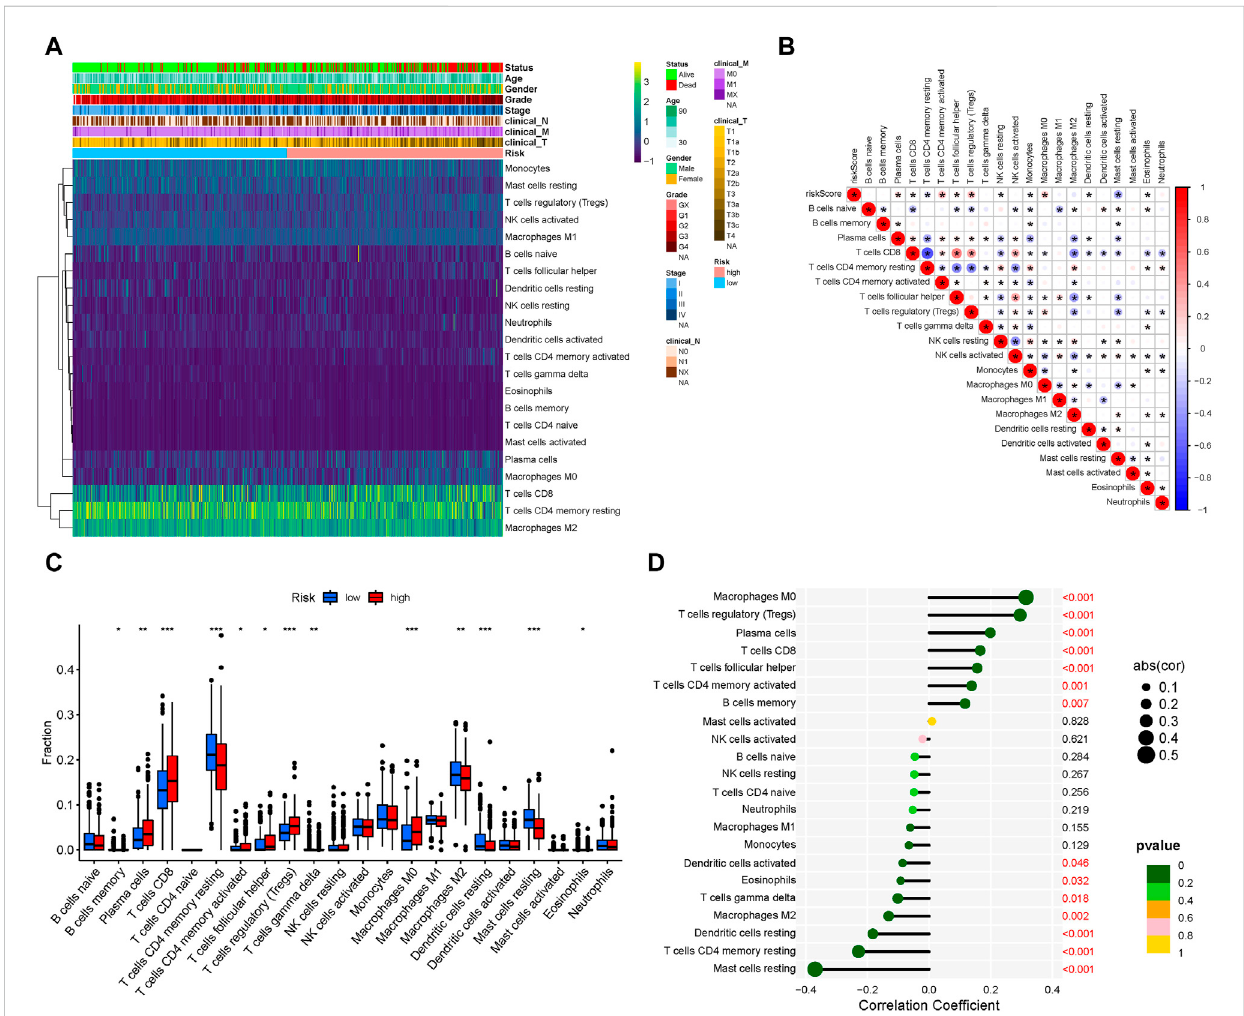
FIGURE 5 Tumor-in fi ltrating immune cell landscape estimation. (A) Heatmap of 22 in fi ltrating immune cell types in the TCGA-KIRC dataset. (B) Correlation between different in fi ltrating immune cell subtypes. Blue represents negative correlation and red represents positive correlation. *, p < 0.05. (C) Differences in distribution of the tumor-in fi ltrating immune cells between high- and low-risk groups. * p < 0.05, ** p < 0.01, *** p < 0.001. (D) Correlation analysis of the risk score and different in fi ltrating immune cell